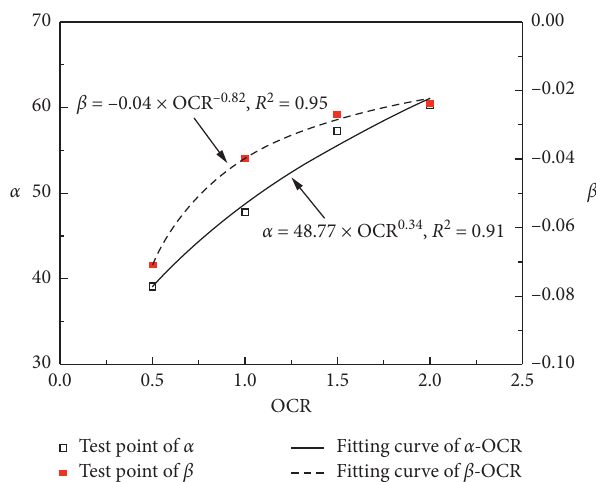
Figure 12: Variations of parameters α and β with different